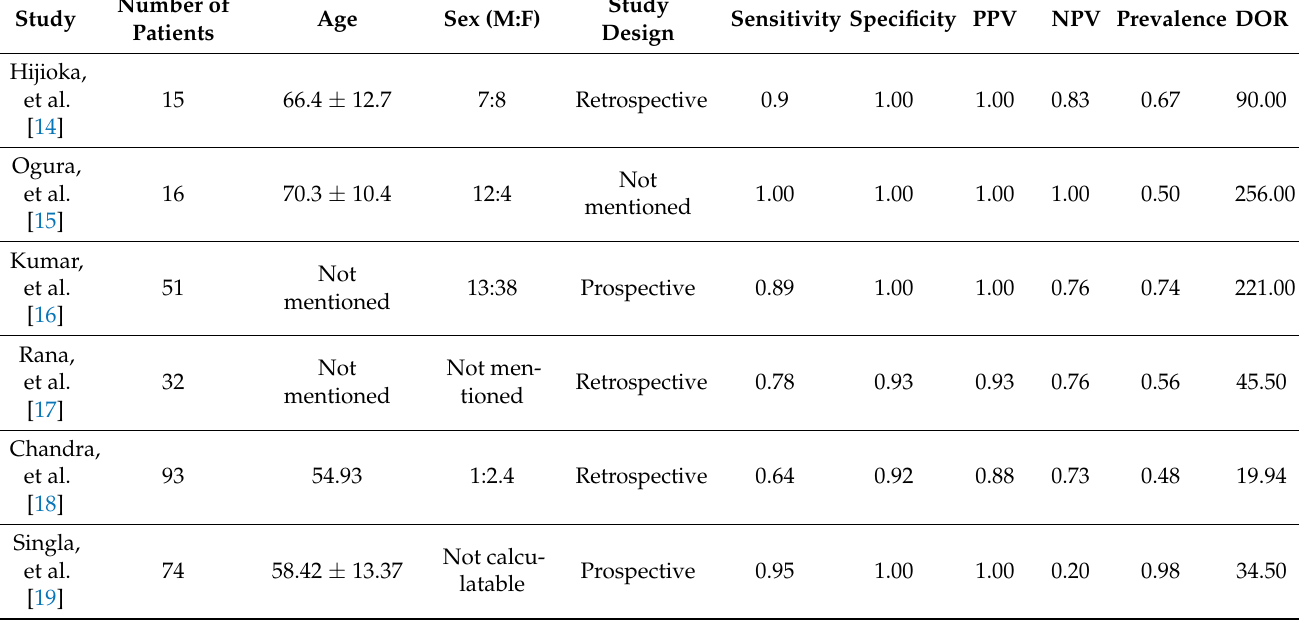
Table 1. Characteristics of each individual study included in the systematic review.